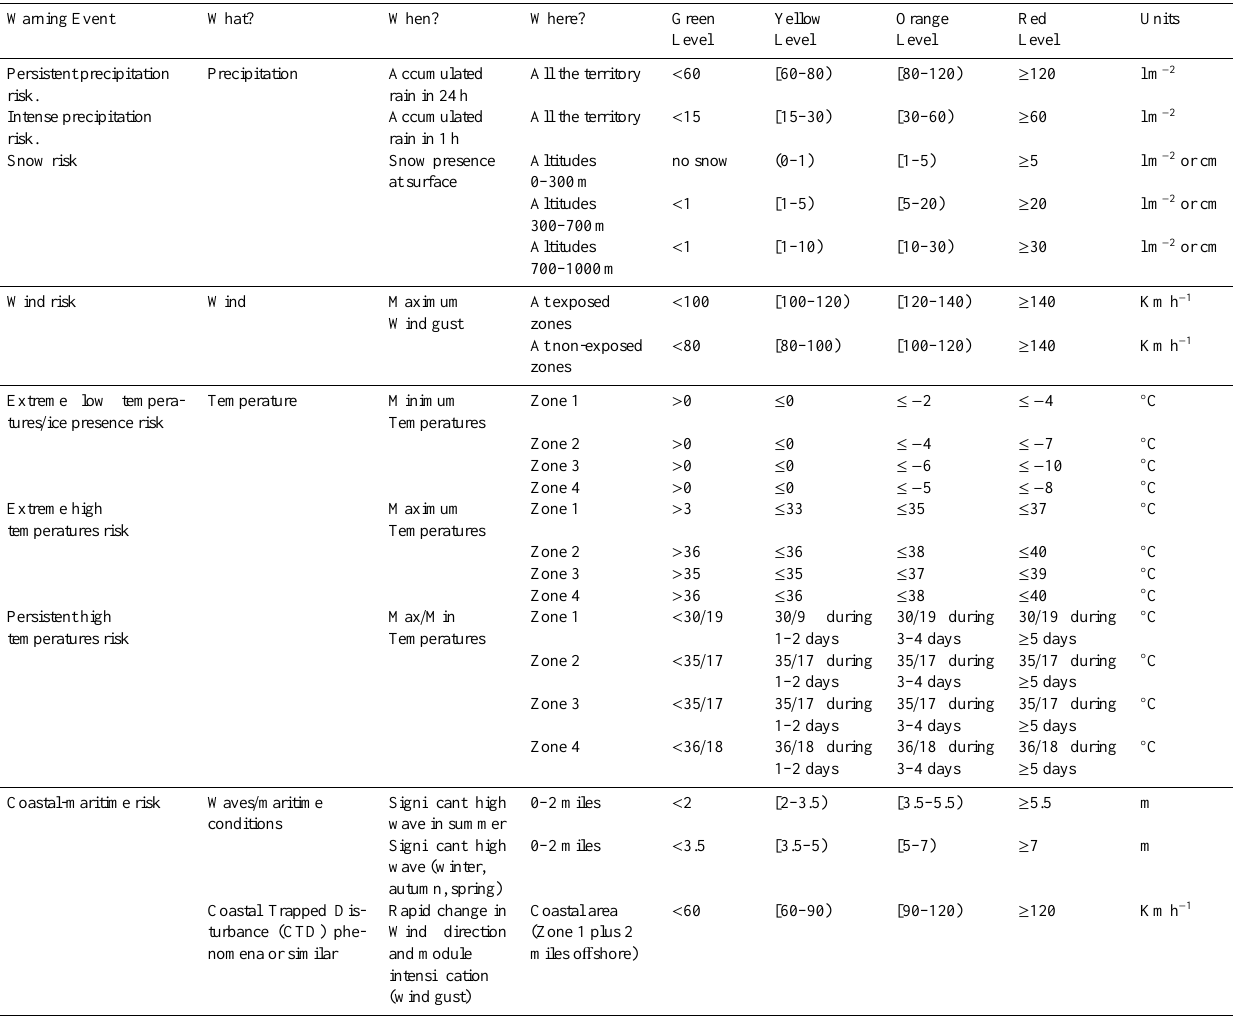
Precipitation Accumulated